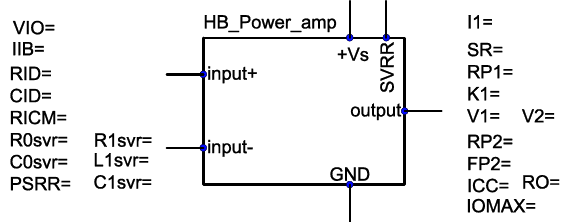
Figure 3. The higher-level block diagram of the proposed macromodel with the modeling parameters.